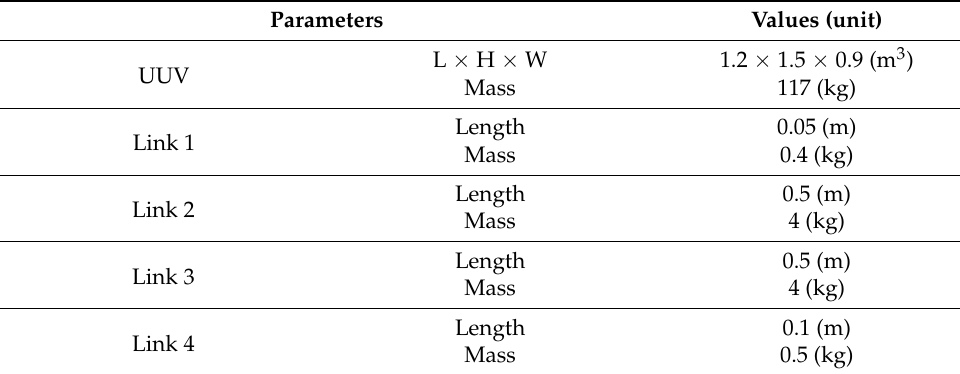
Figure 8. ( a ) A model of the UUV, MM, and work object in V-REP; ( b ) a formed motion trajectory of the MM working tool in V-REP. Table 1. Parameters of the UUV and